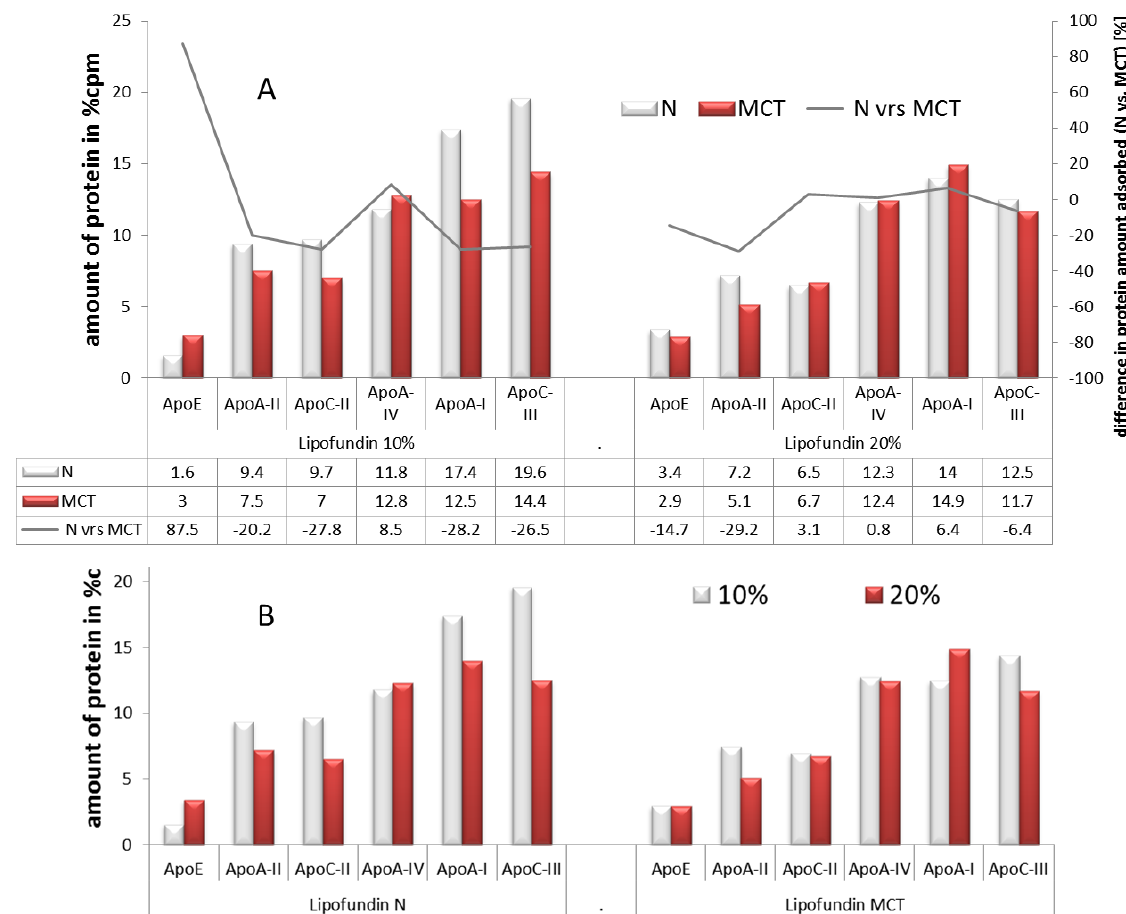
Figure 2. Influence of oil composition on protein adsorption patterns on adsorbed protein type and amount (as a percentage of the overall detected amount of protein, after [105]); ( A ) MCT vs. N for 10% oil content (left) and 20% oil content (right) and the difference in the amount of protein adsorbed given in %; ( B ) 10% vs. 20% oil content for Lipofundin N (left) and Lipofundin MCT